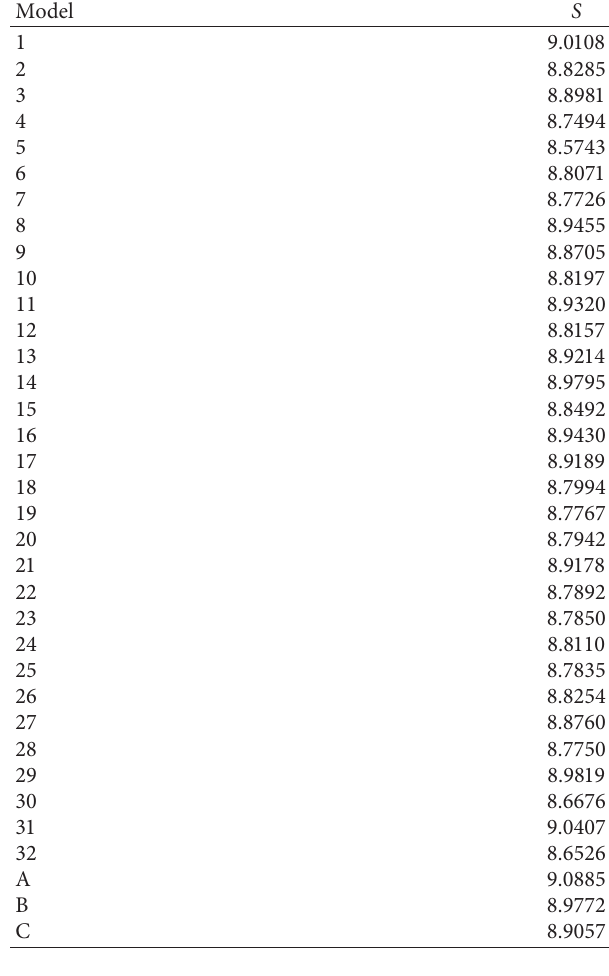
Table 6: “Efficiency-house” of orthogonal tests.